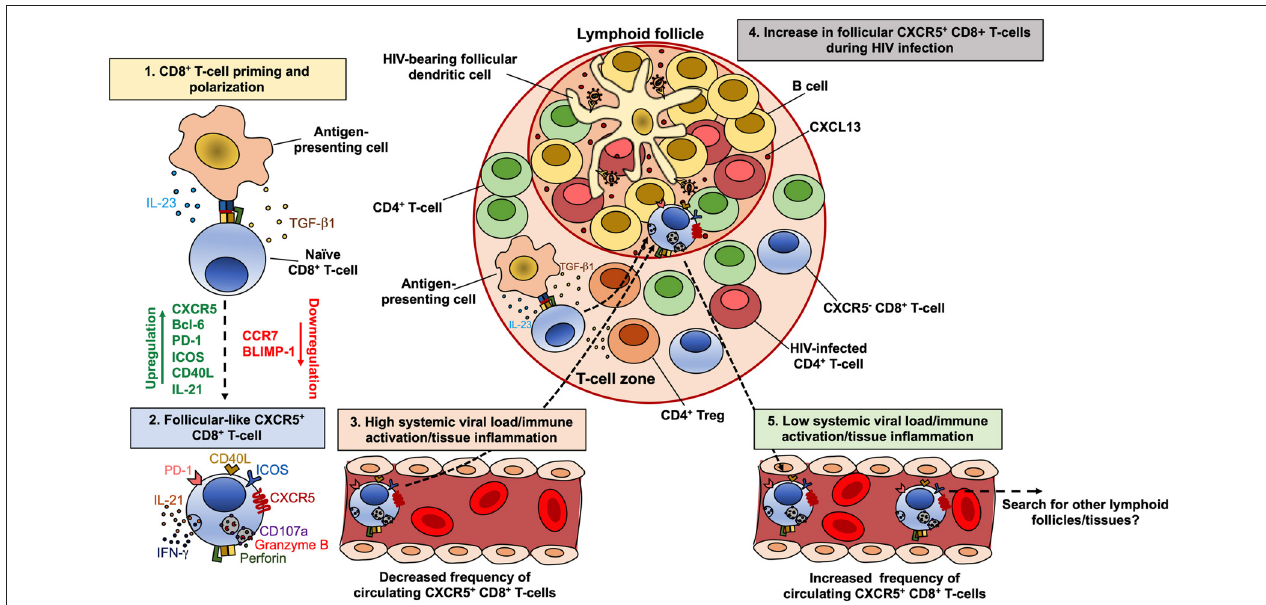
FIGURE 3 | Model of the dynamics of CXCR5 + CD8 + T-cells during HIV infection. CD8 + T-cells are polarized to a follicular-like CXCR5 + profile after priming by an antigen-presenting cell that secrete TGF- β 1 and IL-23 (1). These cytokines induce the up-regulation of CXCR5, Bcl-6, PD-1, ICOS, CD40L and IL-21, with down-regulation of CCR7 and BLIMP-1 (2). In circulation or peripheral tissues, follicular-like CXCR5 + CD8 + T-cells also exhibit a cytotoxic potential and production of IFN- γ . During chronic HIV infection and in the setting of high viral load and consequent increased immune activation and tissue inflammation, there is an accumulation of CXCR5 + CD8 + T-cells in lymphoid follicles, in response to CXCL13 (4). The high levels of TGF- β 1 produced by antigen-presenting cells or regulatory T cells (Treg), may also induce the differentiation and accumulation of CXCR5 + CD8 + T-cells. Once in the follicles, CXCR5 + CD8 + T-cells exert an antiviral effect, which can be reflected in lower viral replication and the subsequent decrease in the immune activation/tissue inflammation and the egress of this subset from follicles. In circulation, CXCR5 + CD8 + T-cells possibly search for other lymphoid follicles or peripheral tissues (5).